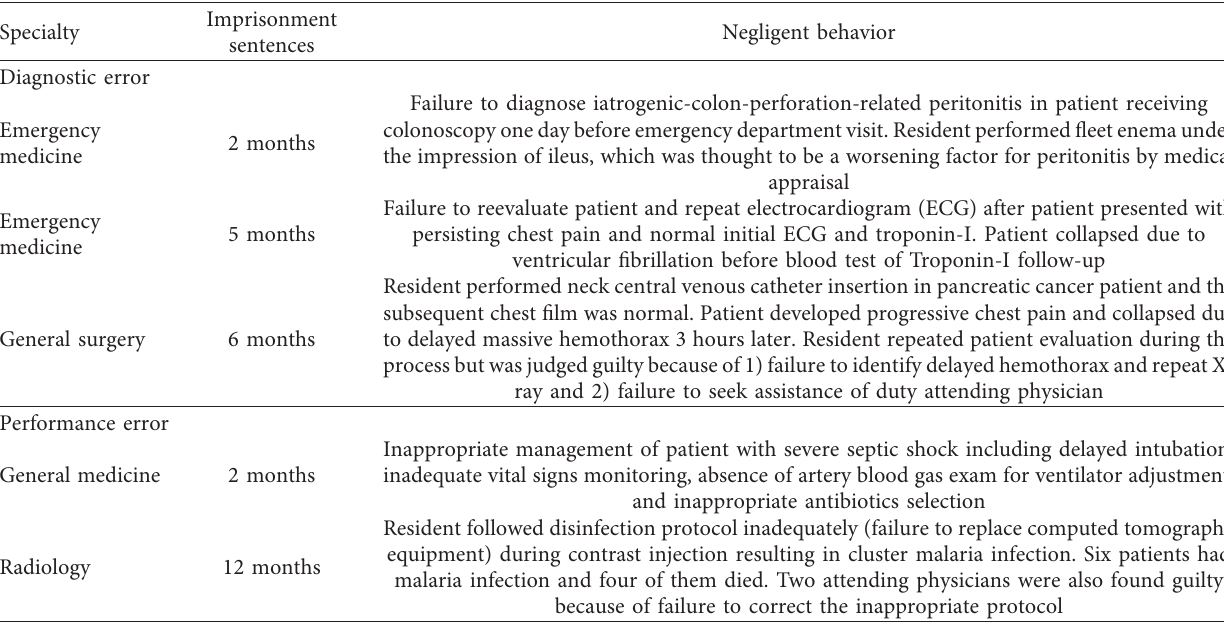
Table 5: Imprisonment sentences and summary of negligent behaviors in the five guilty